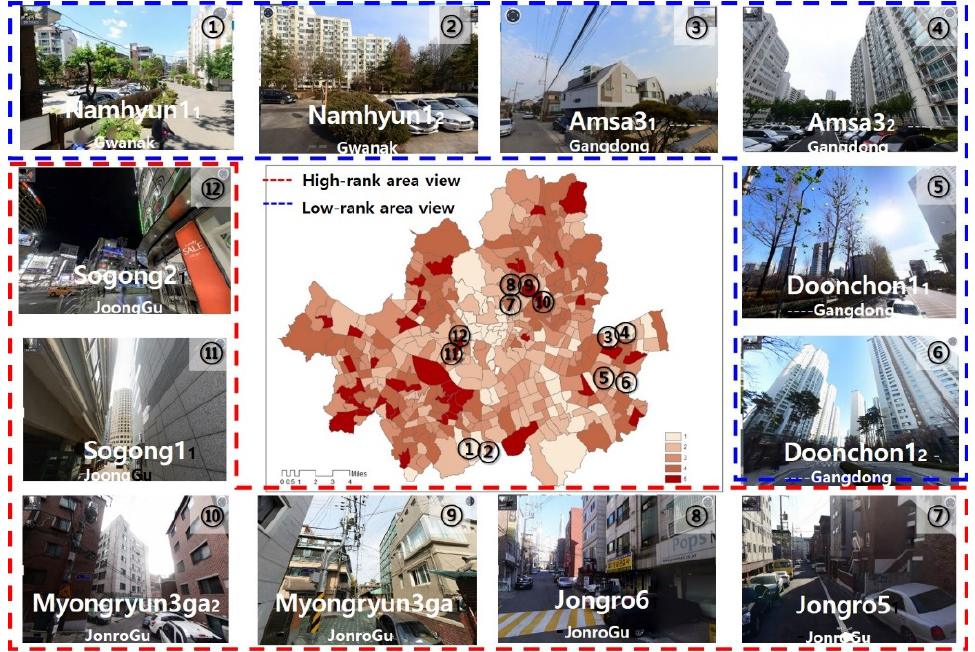
Figure A3. Street views of top three-ranked and bottom three-ranked communities for thermal sensitivity.